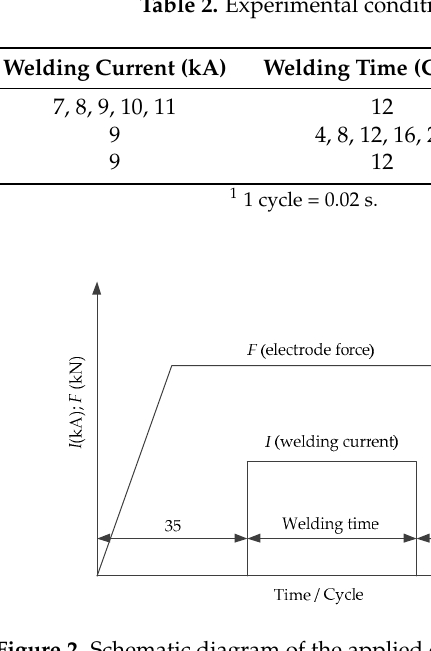
Figure 2. Schematic diagram of the applied of welding current.